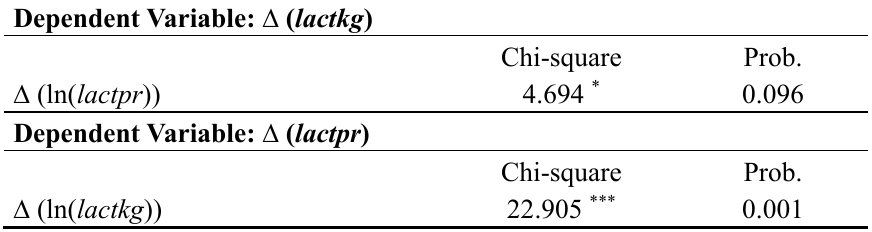
Table 9. Granger causality tests. VEC Granger causality/block exogeneity Wald